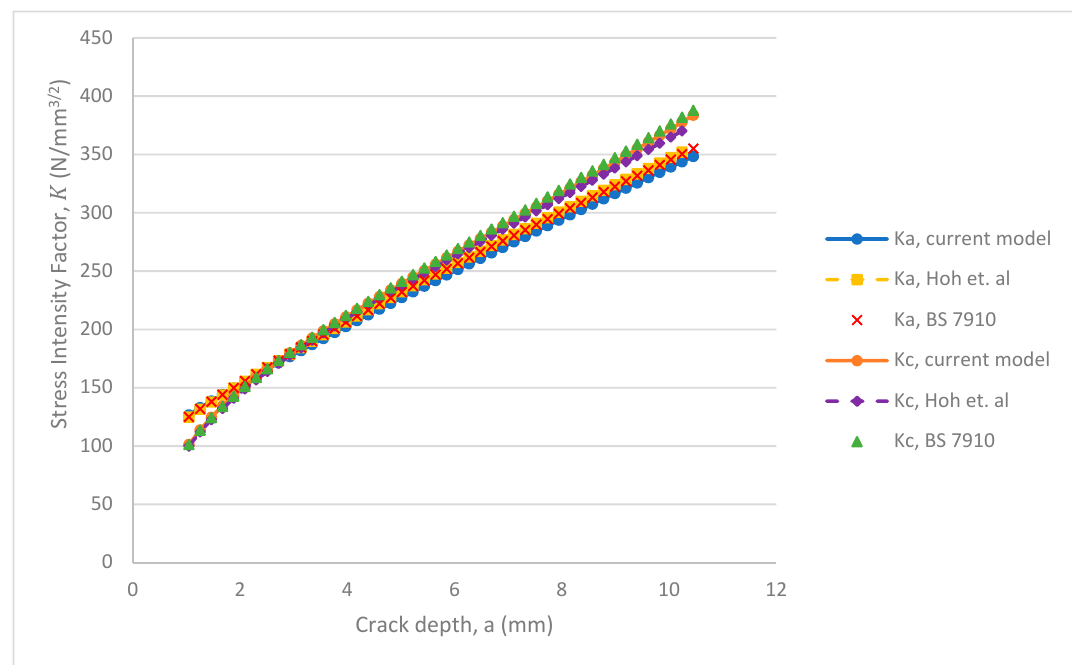
Figure 20. SIFs at the deepest point ( K a ) and surface point ( K c ) for an external semi-elliptical crack in a pipe under cyclic tension (initial a/c = 0.5).